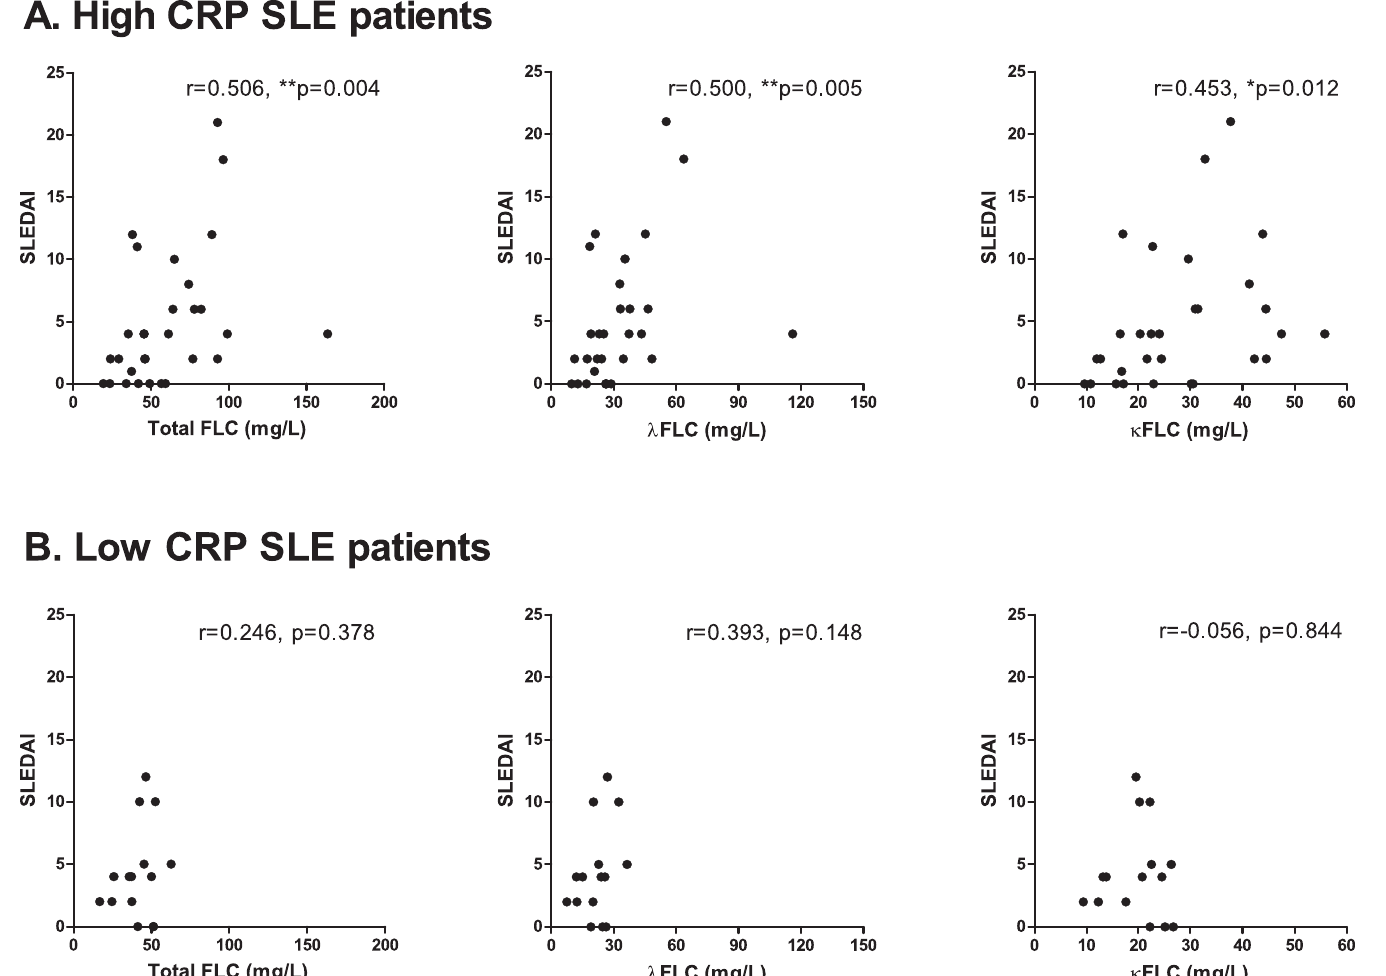
Fig 8. Correlation between serum FLC concentrations and SLEDAI scores in SLE patients with high CRP. Correlation between SLEDAI scores and total FLC, λ FLC and κ FLC levels in high CRP SLE patients (A) (n = 30) and in low CRP SLE patients (B) (n = 15). A: High CRP SLE patients . r-values are